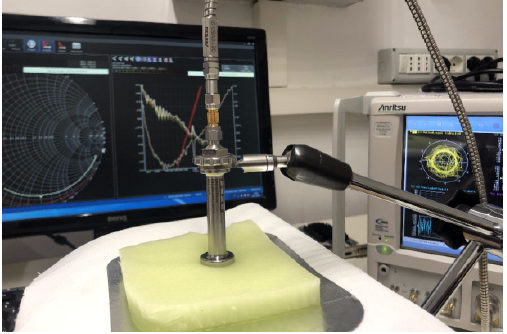
Figure 1. Test setup in the Microwave Laboratory at University of Calabria.